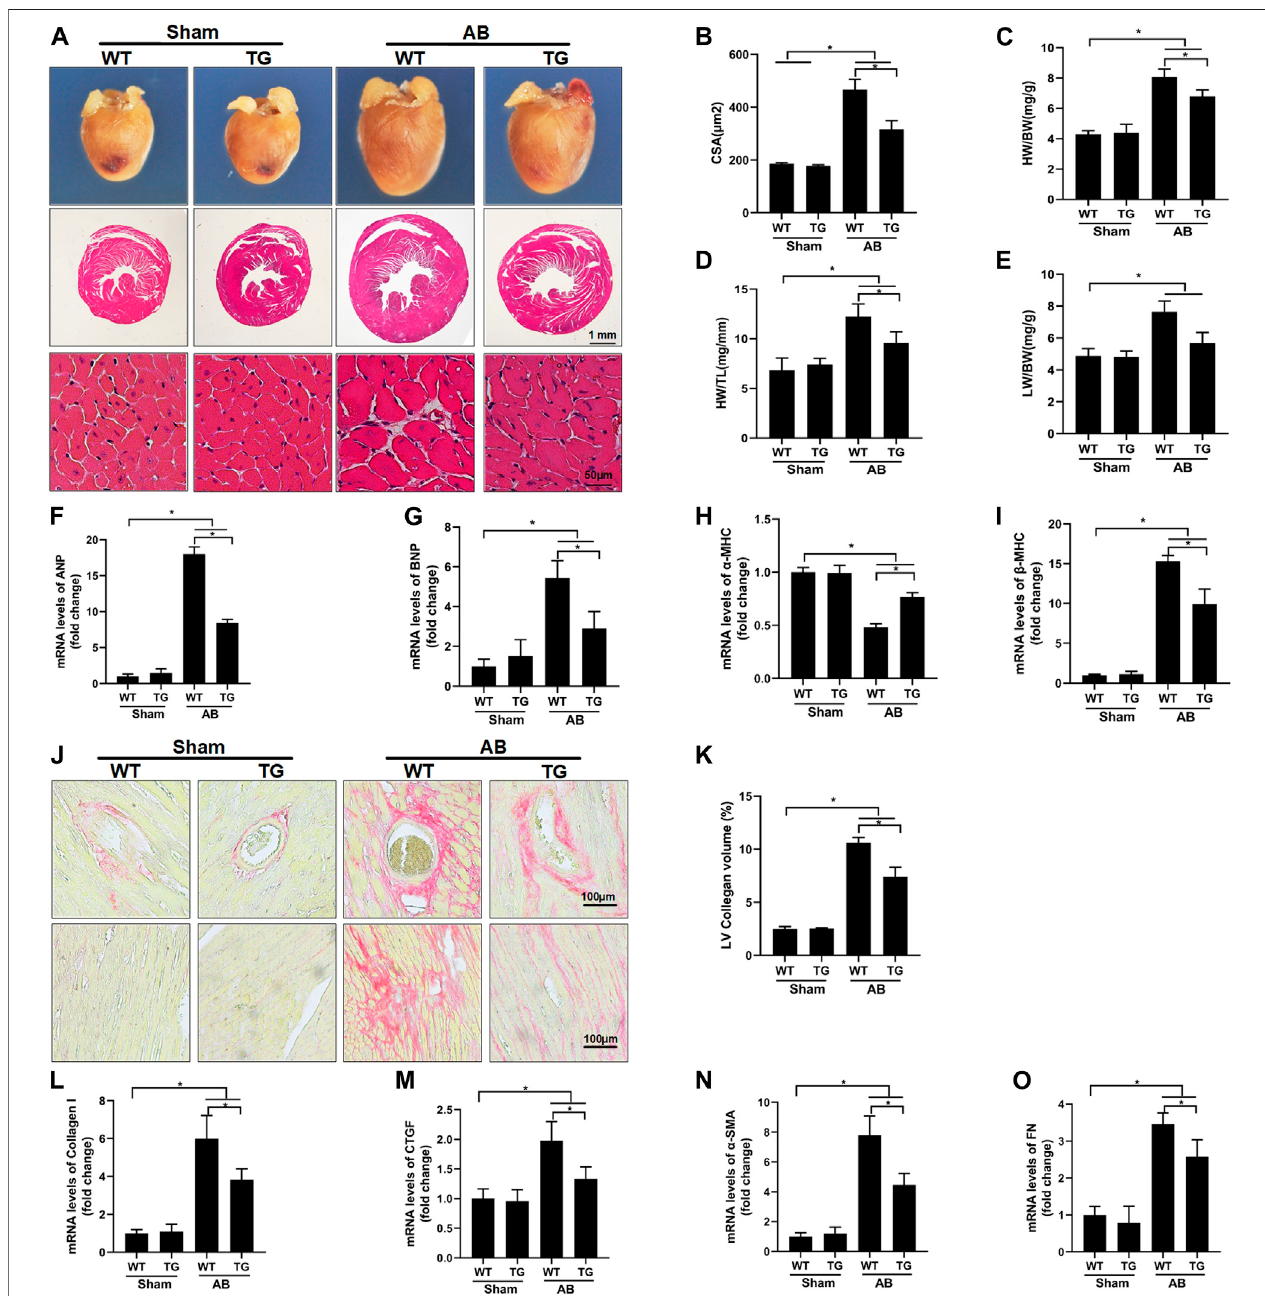
FIGURE 3 | Sesn2 overexpression alleviated pressure overload-induced hypertrophy and fi brosis in mice. (A) Representative images of gross hearts and HE staining in the indicated groups ( n (cid:1) 6). (B) Quanti fi cation of the cross-sectional area (CSA) of cardiomyocytes in the indicated mice ( n ≥ 100 left ventricular cells). Statistical resultsofthe (C) HW/BW, (D) HW/TL (E) and LW/BW ofmice at 8 weeksafter ABsurgery( n (cid:1) 9). Cardiac mRNA levels of. (F) ANP, (G) BNP, (H) α -MHC,and (I) β -MHC. (J) Picrosirius red (PSR) staining of histological sections of left ventricles ( n (cid:1) 6), (K) quantitative results of the left ventricular collagen volume ( n ≥ 25 fi elds).L-O The mRNA levels of (L) Collagen I, (M) CTGF, (N) α -SMA,and (O) FN. ANP: atrial natriuretic peptide; BNP, brainnatriuretic peptide; α -MHC, α -myosin heavy chain; β -MHC, β -myosin heavy chain; HW, heart weight; BW, body weight; TL, tibia length; HE, hematoxylin and eosin; CTGF, connective tissue growth factor; FN, fi bronectin; α SMA, alpha-smooth muscle actin ( α SMA). The data were expressed as the mean ± SD. * p < 0.05 vs. indicated group. One-way analysis of variance (ANOVA) followed by Tukey post hoc tests were used for signi fi cance analysis.